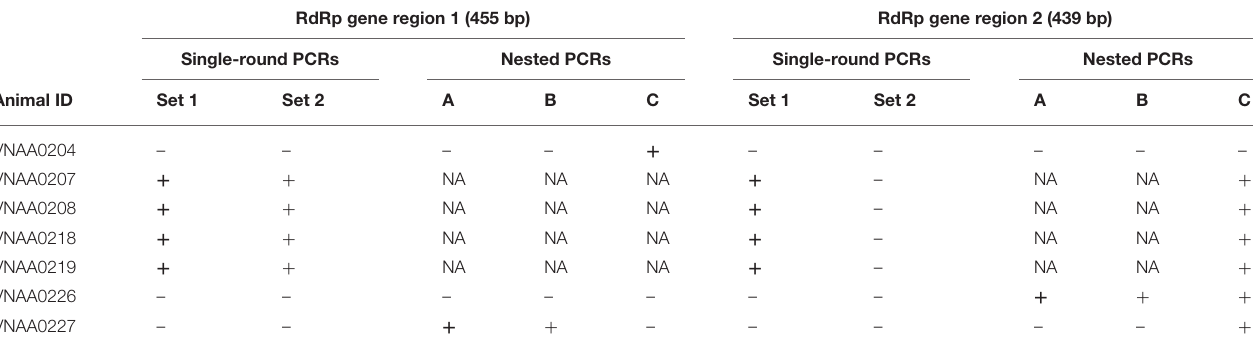
PCR results highlighted in bold were selected for sequencing. Nested PCR A corresponds to primer set 1 (round 1) and set 2 (round 2), nested PCR B to set 1 (round 1), and set 3 (round 2), and nested PCR C to set 2 (round 1) and set 3 (round